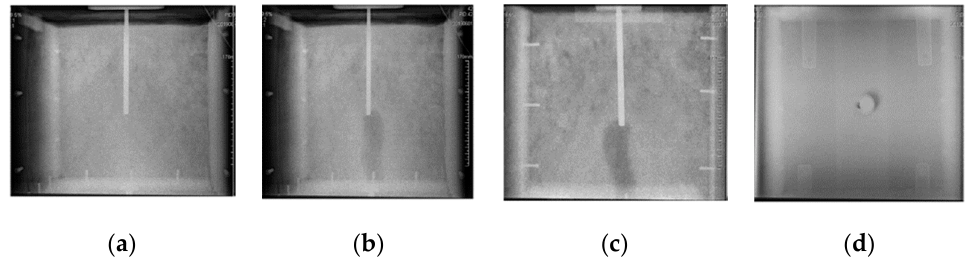
Figure 17. Images of modified soil with water content of 10%: ( a ) Before breakdown; ( b ) front view; ( c ) side view; ( d ) top view.